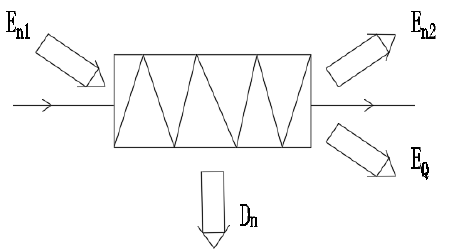
Figure 3 is a schematic diagram of the condenser exergy balance model. The exergy entering the condenser is the condenser inlet working fluid exergy E n 1 , and the condenser output exergy includes the condenser outlet working fluid exergy E n 2 , the system heating